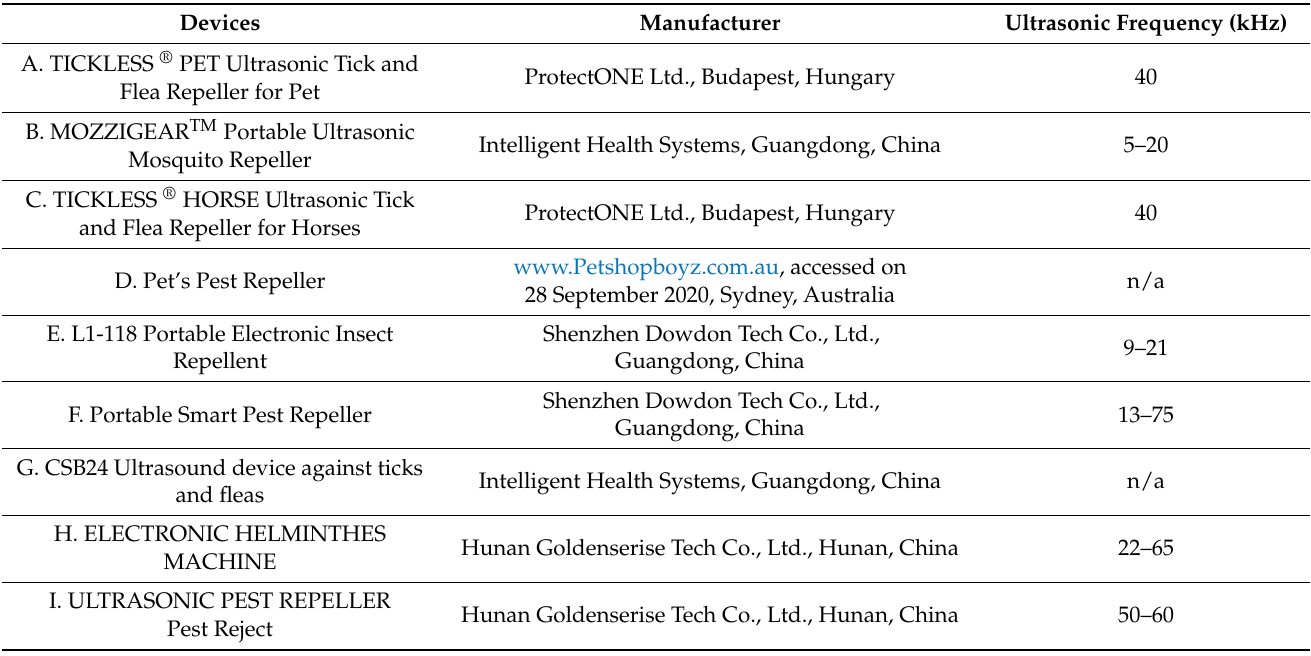
Table 1. The nine ultrasonic devices used, along with their frequency (in kilohertz), as stated by the